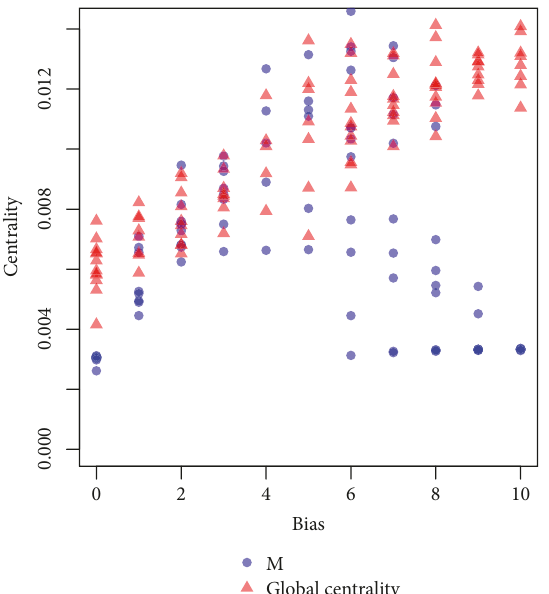
Figure 6: Individuals’ centrality and bias values in Simulation 2. Thecentralityvalue of an individual is computedusing two methods (mediation centrality and global centrality) and shown on the y-axis asa functionof theindividual’s bias. Bias is shownhereas theinteger number of reasons on the pro side (i.e., 10𝛽